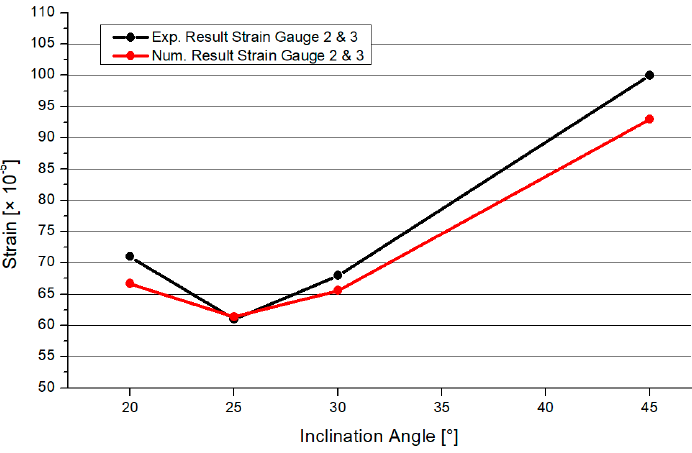
Figure 12. Comparison of the results of both CHS profiles.